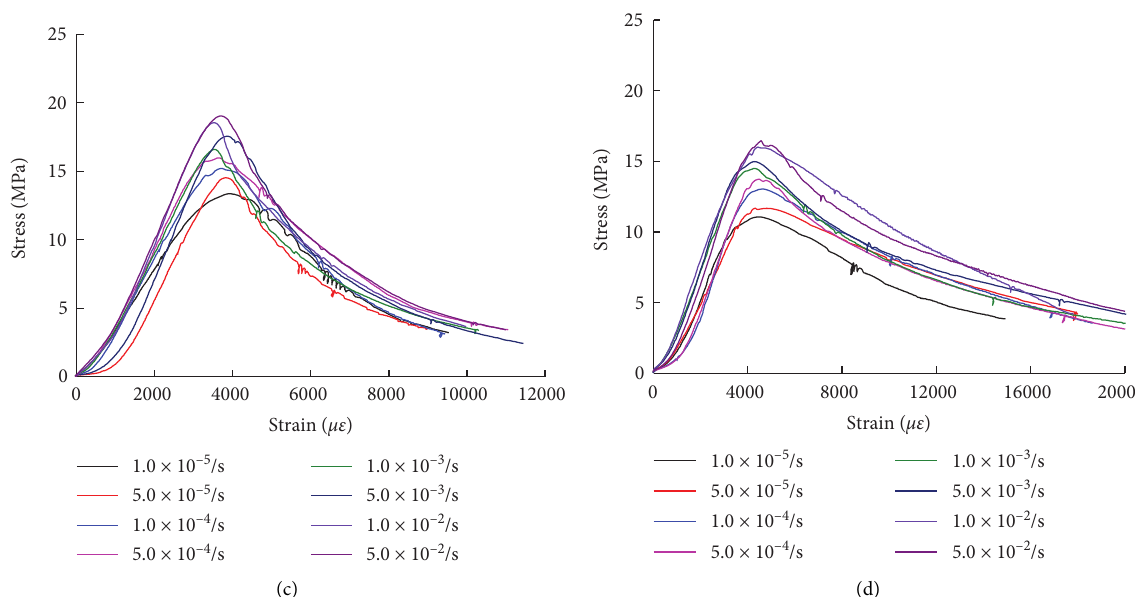
Figure 6: The compressive dynamic stress-strain curves of rubber concrete under the action of different numbers of freeze-thaw cycles. (a) D-0. (b) D-50. (c) D-100. (d) D-150.